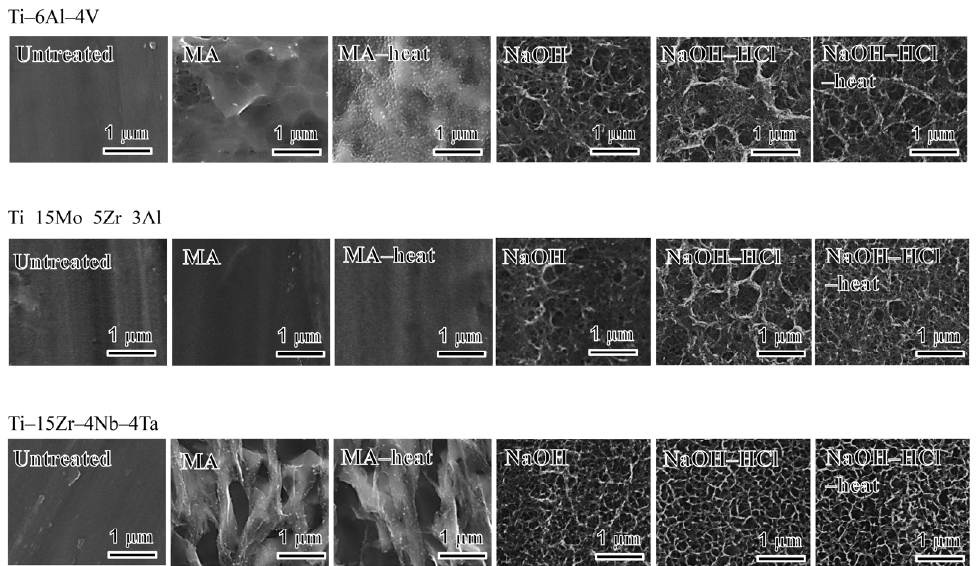
Figure 1. FE-SEM micrographs of the surfaces of various types of alloys untreated and subjected to mixed acid and subsequent heat treatments, or NaOH, HCl and subsequent heat treatments. MA: mixed acid treatment, MA-heat: mixed acid and heat treatment, NaOH: NaOH treatment, NaOH-HCl: NaOH and HCl treatment, NaOH-HCl-heat: NaOH, HCl and heat treatment.